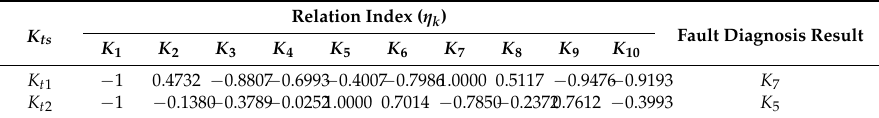
Table 7. Relation indices and fault diagnosis results of steam